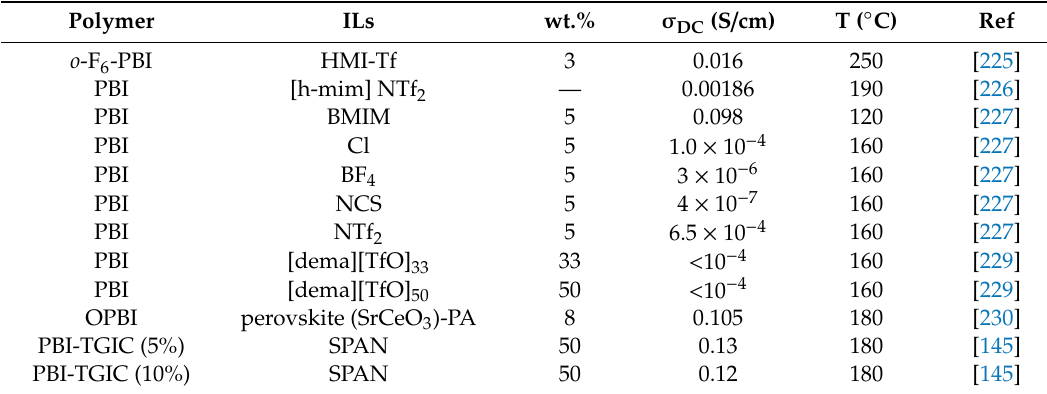
Composite membranes of polybenzimidazole with ionic liquids (ILs). HMI-Tf, 1-hexyl-3-methylimidazolium trifluoromethanesulfonate; BMIM, 1-butyl-3-methylimidazolium; SPAN, Figure 22. Number of publications in the period of 2001–2019 indexed in the Web of Science: ( A ) keywords: ionic liquid AND fuel cell; and ( B ) keywords: ionic liquid AND fuel cell AND proton exchange membrane. Source: www.webofknowledge.com.